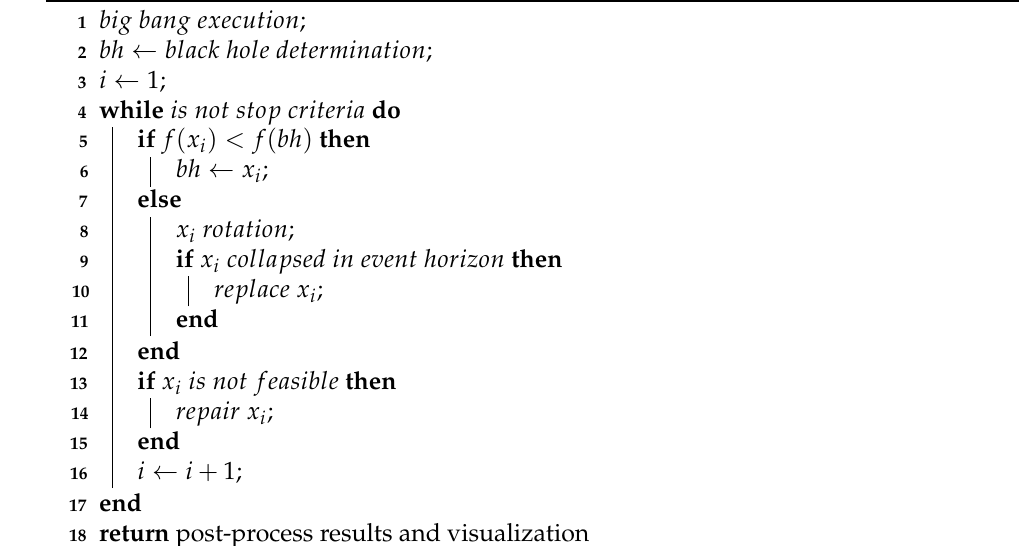
Algorithm 1: Binary black hole